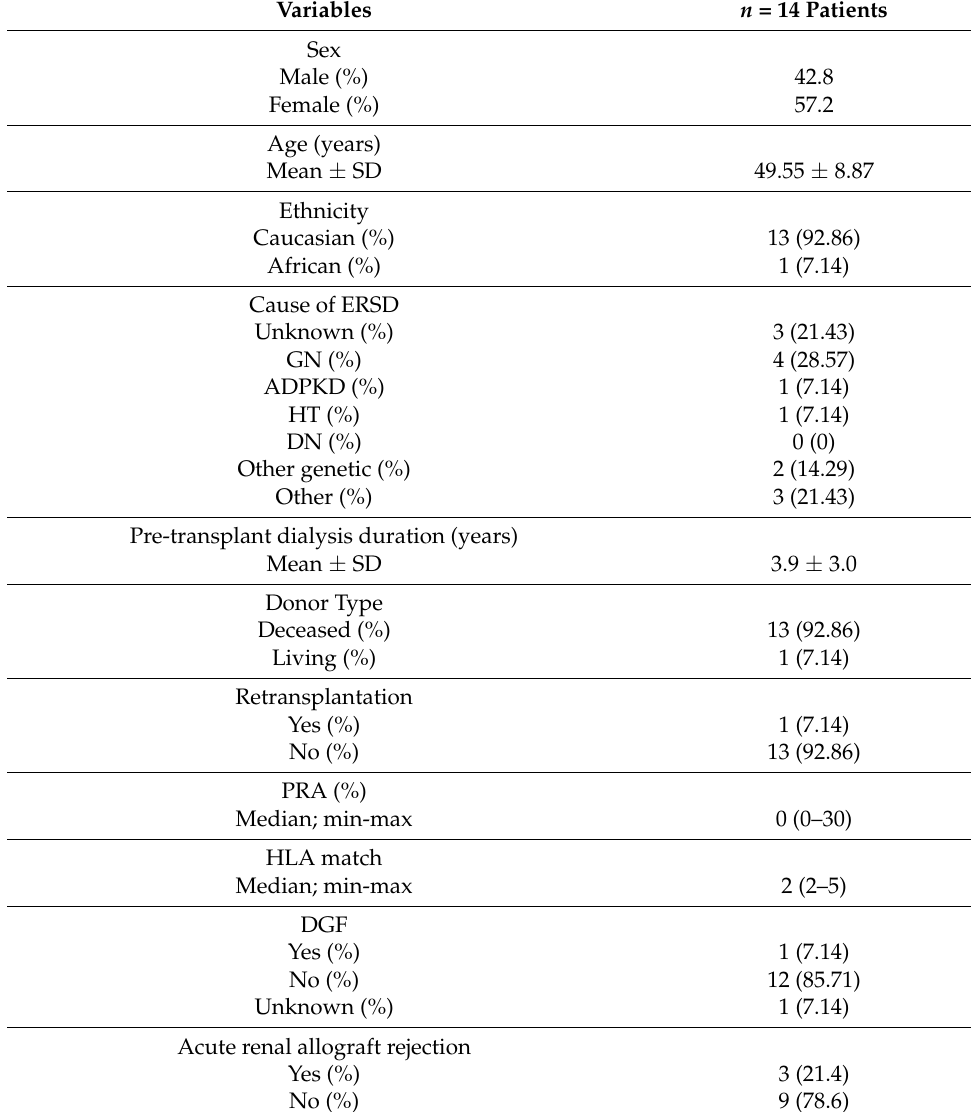
Table 1. Demographic and clinical characteristics of the enrolled patients at the